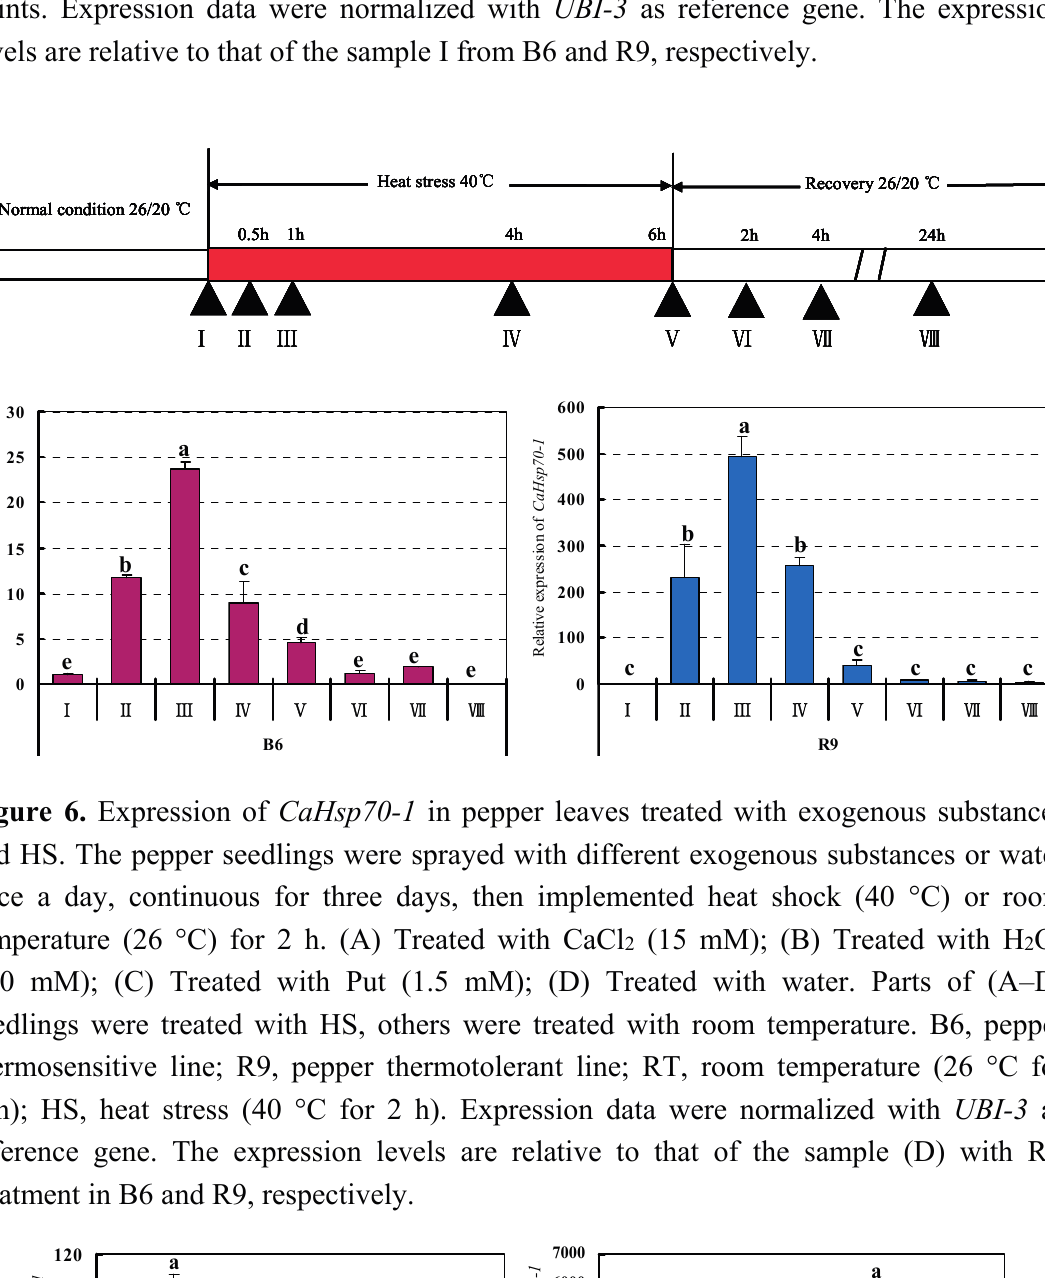
Figure 5. Expression of CaHsp70-1 in pepper responses to HS treatment. B6, pepper thermosensitive line; R9, pepper thermotolerant line. ( a ) The time course of HS treatments. Triangles indicate the time points when the leaves were collected (sample I–VIII); ( b ) Expression profiles of CaHsp70-1 in pepper leaves by HS treatment at different time points. Expression data were normalized with UBI-3 as reference gene. The expression levels are relative to that of the sample I from B6 and R9, respectively.